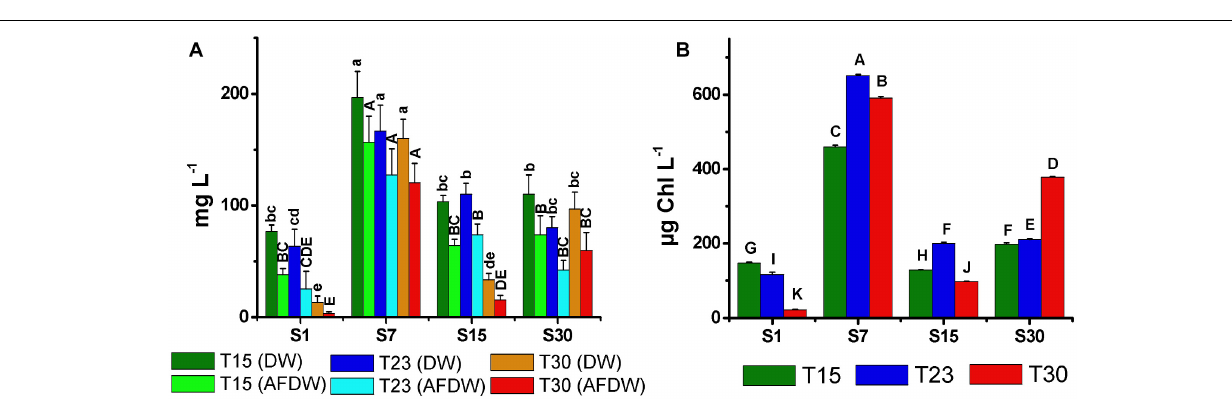
FIGURE 6 | Total biomass dry weight (DW), ash free dry weight (AFDW) (A) , and mean concentration of chlorophyll- a (B) of N. spumigena (NODSPU1) ( ± SD; n = 3). Significant difference between treatments is indicated by letters (ANOVA, Tukey’s p < 0.05). Lower case for DW and upper case for